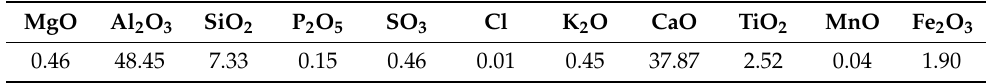
Table 1. Chemical composition of CAC (wt %).